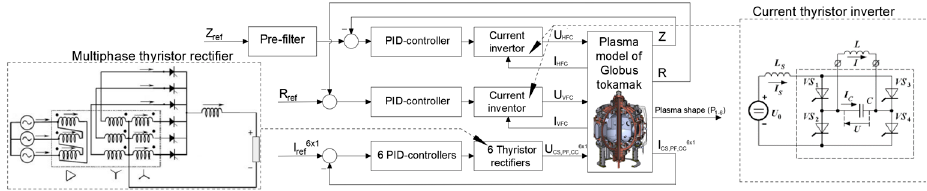
Figure 3. Block diagram of the Globus-M/M2 plasma control system.